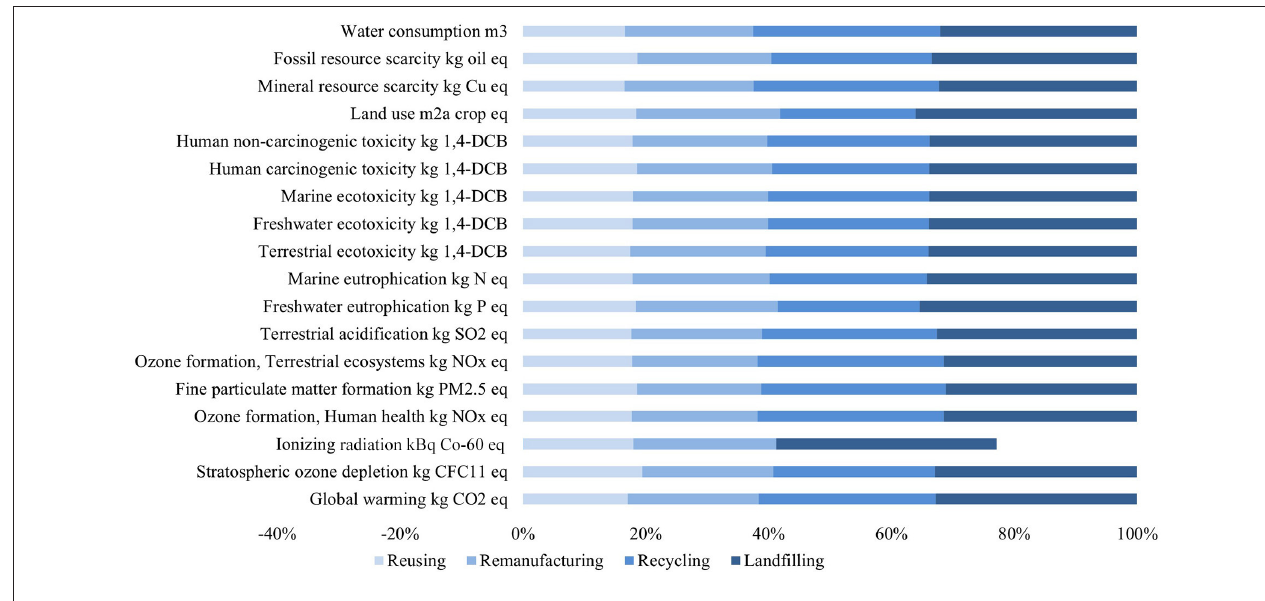
FIGURE 4 | Environmental impact of RL strategies.